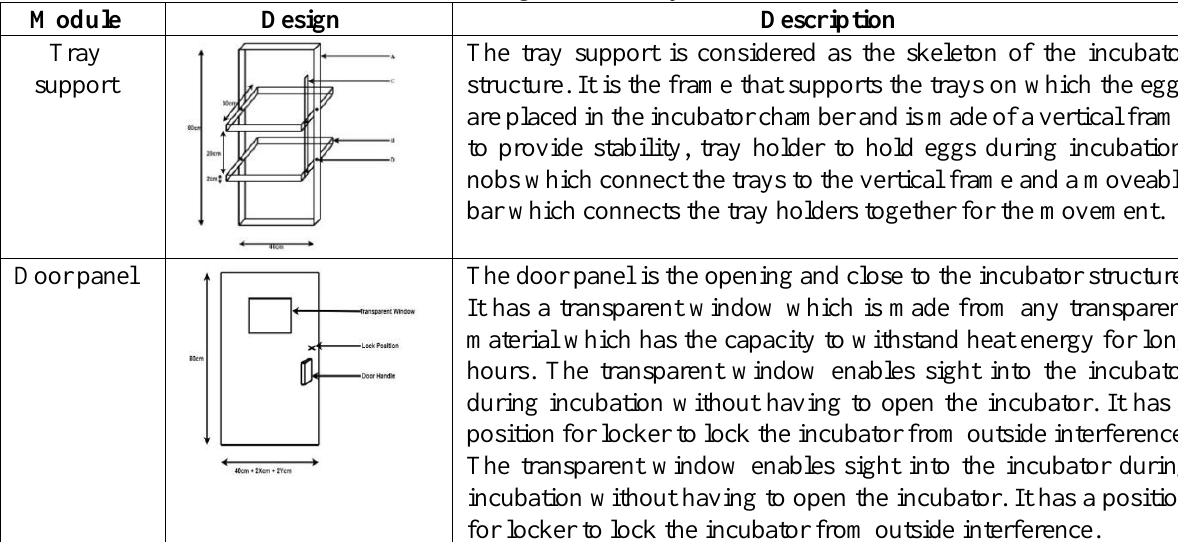
Table 1. DigiIncubator System